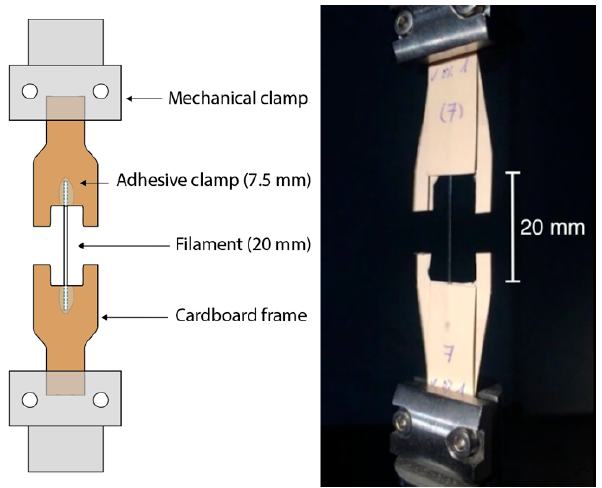
Figure 3. Tensile test clamp-scheme used to avoid inducing mechanical damage with the mechanical clamps.